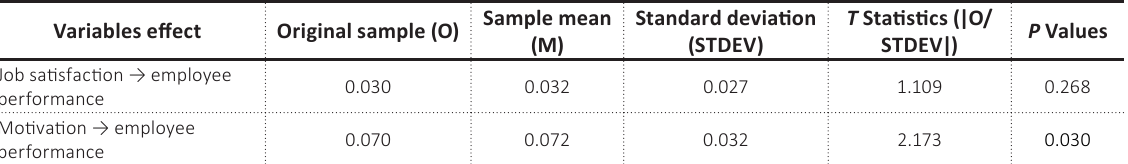
Table 8. Summary of the structural